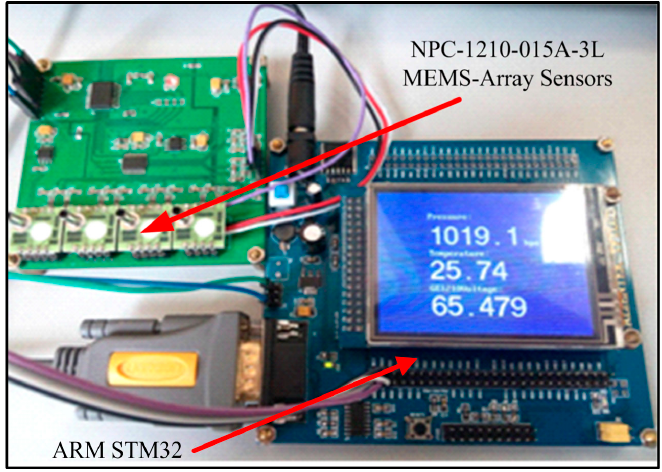
Figure 2. Photograph of the designed digital MEMS-array pressure